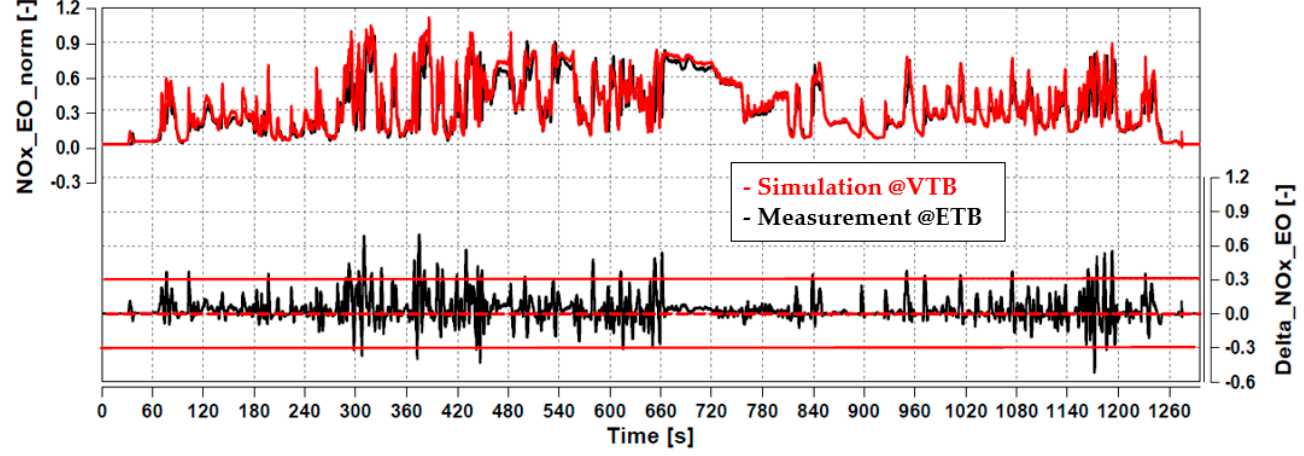
Figure 16. Measured ( x -axis) vs. Simulated ( y -axis) Soot emission at Engine Out (normalized). However, even if the correlation between simulation and test is less satisfactory for soot than it is for other variables, the number of simulated points is in a “safety region”